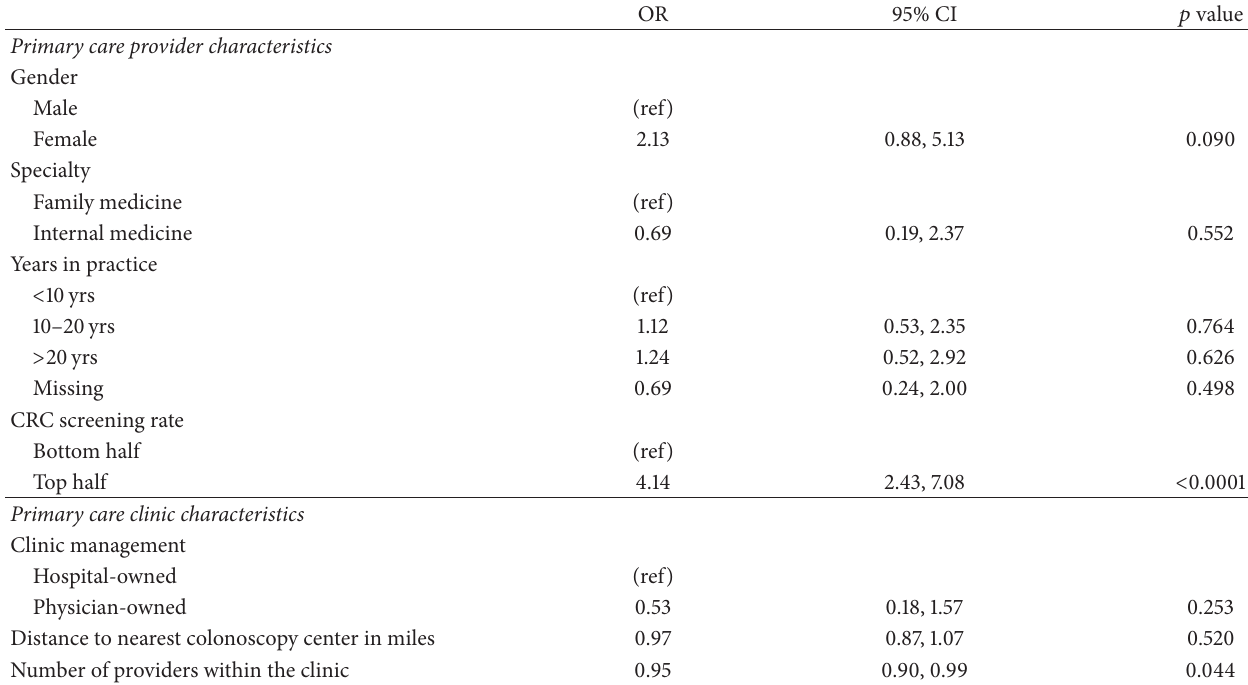
Table 2: Adjusted odds ratios and 95% confidence intervals for provider and clinic predictors of membership in PCP group perceiving multiple barriers ( 𝑁 = 166